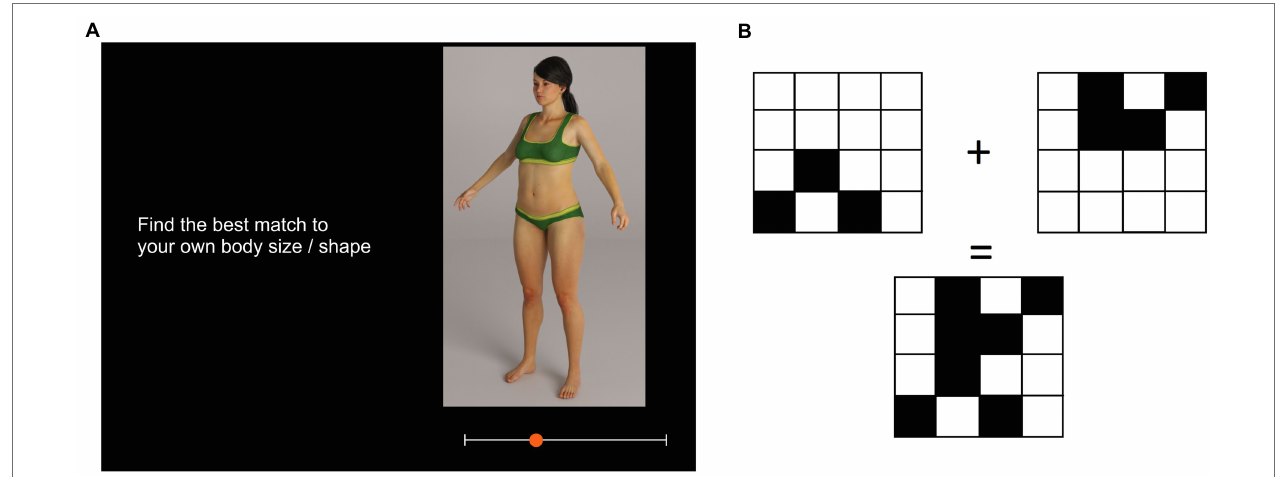
FIGURE 1 | Schematics to illustrate: (A) The appearance of the stimulus, response slider, and task reminder on one trial of the MoA for self-estimation of body size, and (B) the appearance of the stimuli on one trial of the distractor